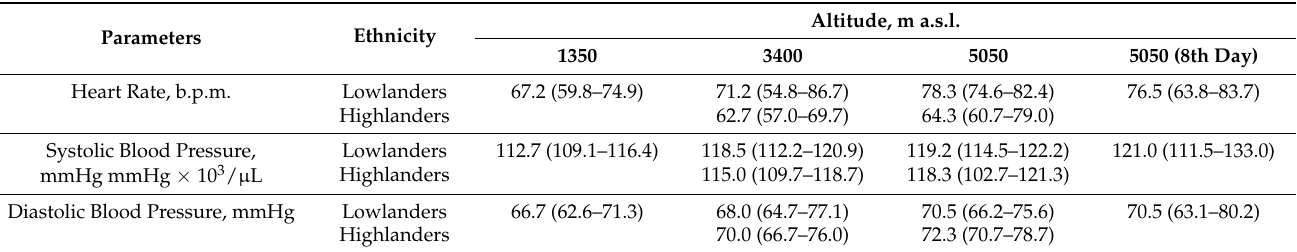
Table 3. Heart rate and blood pressure changes with altitude in European lowlanders and Nepalese